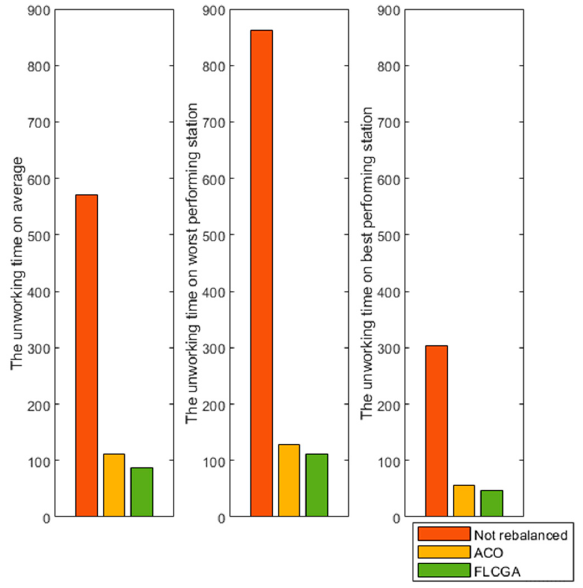
Figure 20. Performance comparison: unworking time (seconds).